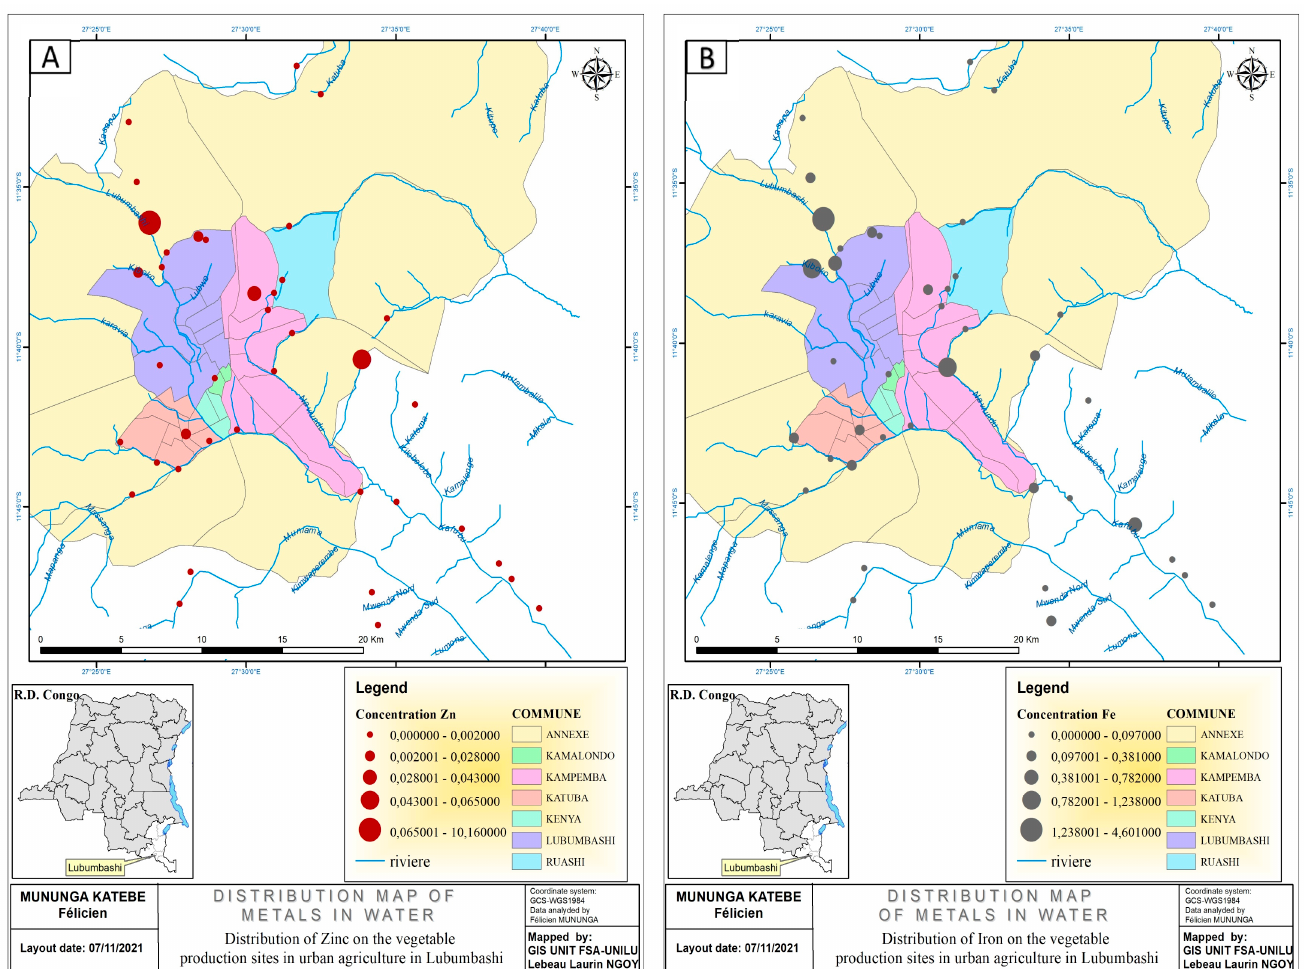
Figure 12. Spatial distribution of metals (Zn and Fe) in the waters of Lubumbashi market gardens (A and B).